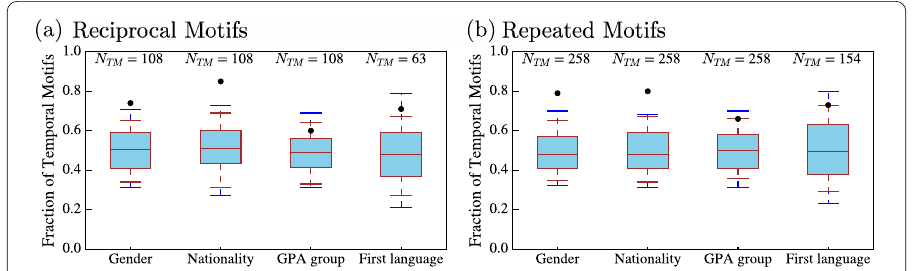
Figure 12 Homophily in temporal motifs—yearly-aggregated communication network. Motif types—reciprocal and repeated events. Data (black dots) are compared with the distribution (boxplots) obtained for a null model in which attributes are reshuffled among nodes. N TM gives the number of temporal motifs in the network. Boxplot: Whiskers—5th, 10th and 90th, 95th percentiles; box—25th and 75th